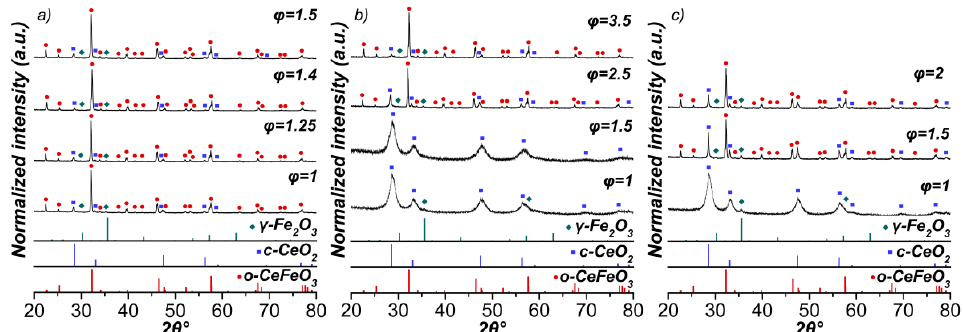
Figure 3. XRD patterns of synthesized materials by ( a ) glycine-nitrate; ( b ) urea-nitrate; and ( c ) urotropine-nitrate combustion at the various fuel-to-oxidizer ratios ( ϕ ) (where o-CeFeO 3 – orthorhombic perovskite CeFeO 3 (JCPDS card no. 00-022-0166); c-CeO 2 –cubic CeO 2 (JCPDS card no. 01-075-8371); γ -Fe 2 O 3 –cubic Fe 2 O 3 (JCPDS card no. 00-039-1346)).